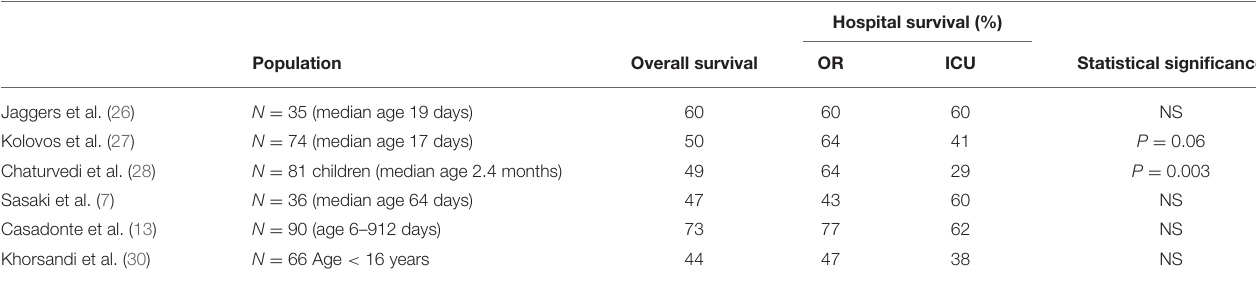
TABLE 3 | Hospital survival based on location of ECMO initiation in either operation room (OR) because of failure to wean from bypass or in the intensive care unit (ICU) due to low cardiac output syndrome or hypoxia (7, 26–30).